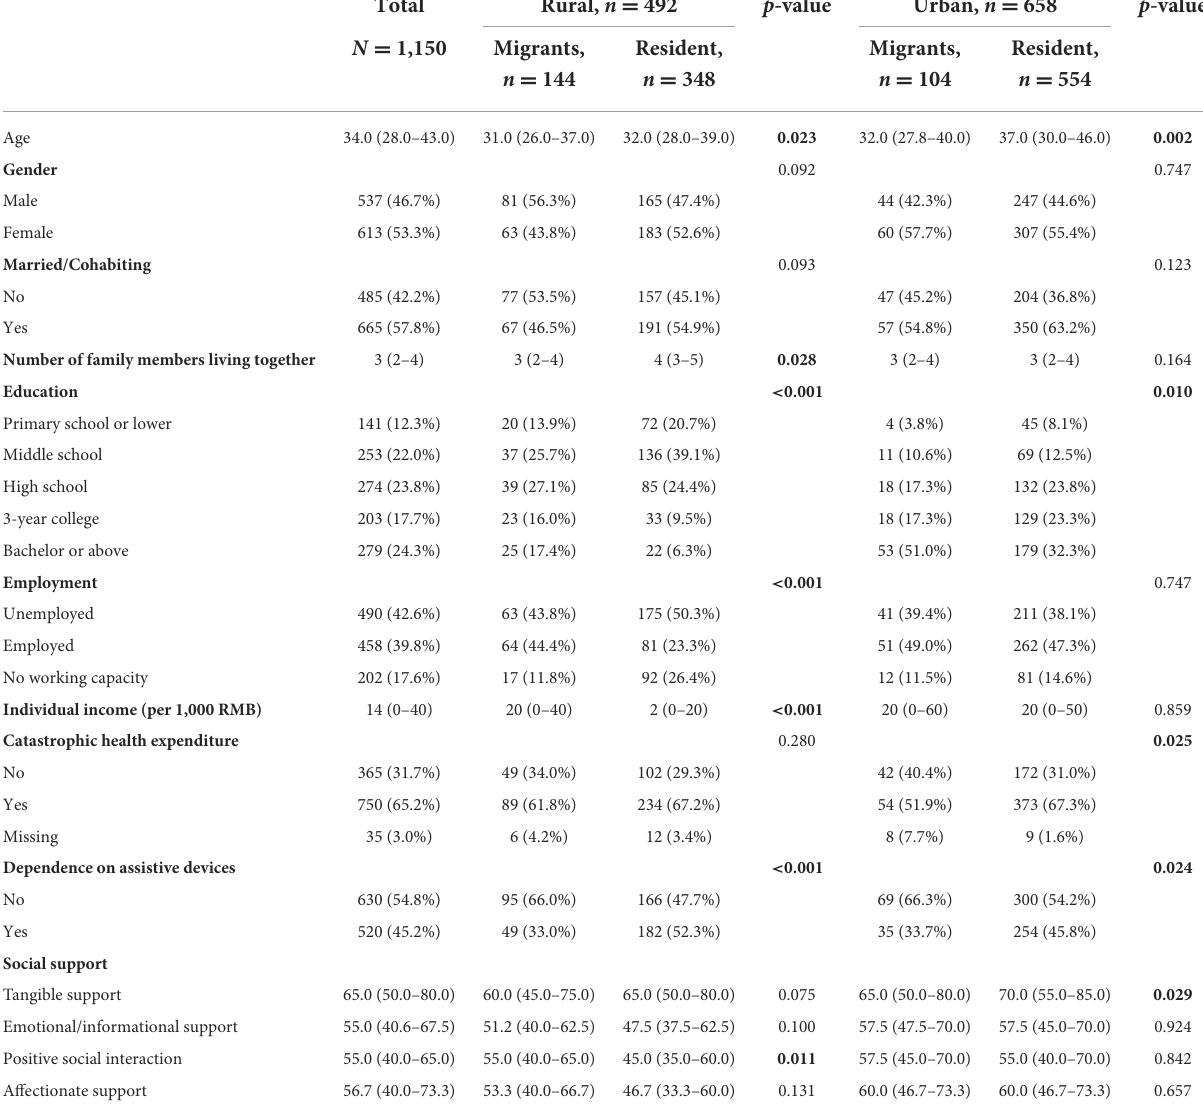
TABLE 1 Descriptive characteristics of urban and rural adults with rare diseases by migration